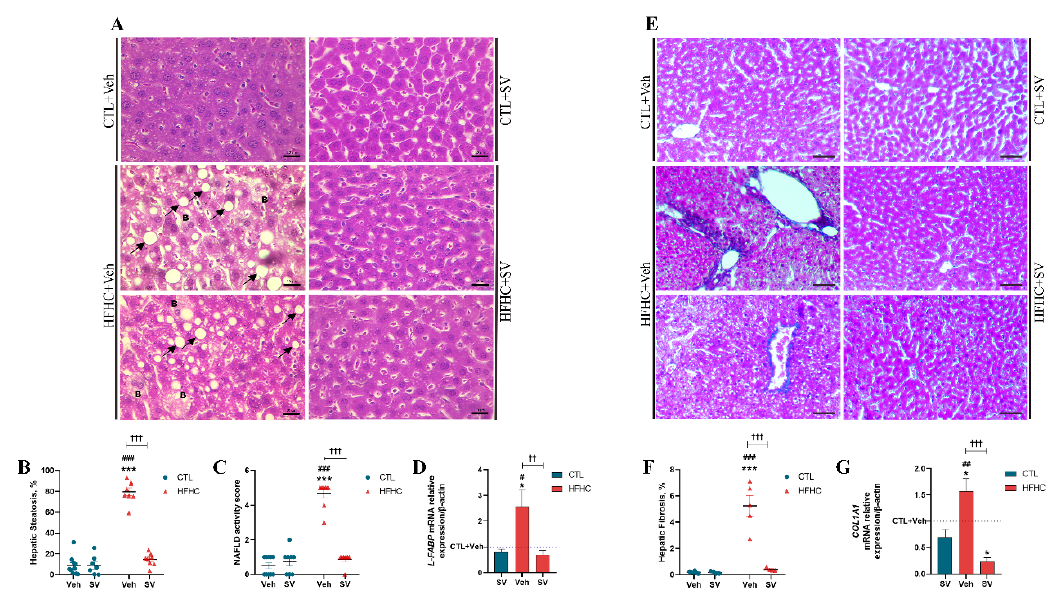
Figure 2. SV protects against HFHC-induced hepatic steatosis and fibrosis progression. Representative images of histological analyses via hematoxylin-eosin staining of the livers from mice fed control diet (CTL+Veh), control diet plus SV (CTL+SV), HFHC diet (HFHC+Veh), or HFHC diet plus SV treatment (HFHC+SV) ( A ). Quantification of percentage of hepatic steatosis is represented in ( B ) and NAFLD activity score (NAS) in ( C ). Real-time PCR analyses of mRNA transcript levels of gene encoding liver-type fatty acid-binding protein ( L-FABP ) is shown in ( D ). Representative images of histological analyses via Masson’s trichrome staining of the livers from the CTL+Veh, CTL+SV, HFHC+Veh or HFHC+SV group ( E ). ( F ) Demonstration of quantification of percentage of hepatic fibrosis area. Real-time PCR analyses of mRNA transcript levels of gene encoding collagen type I alpha 1 ( COL1A1 ) is shown in ( G ). Arrow: Lipid vacuoles; Letter B: Hydropic degeneration. * p < 0 vs. CTL+Veh; *** p < 0.001 vs. CTL+Veh; # p < 0.05 CTL+SV; ## p < 0.01 CTL+SV; ### p < 0.001 vs. CTL+SV; †† p < 0.01 HFHC+SV; ††† p < 0.001 HFHC+SV.